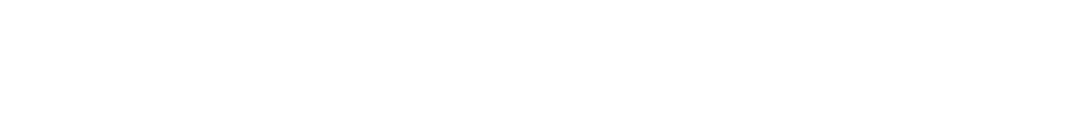
Frontiers in Oncology | Cancer Epidemiology and